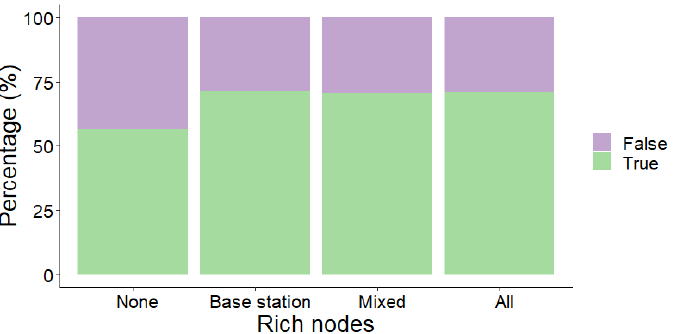
Figure 16. Deployment distribution between usage of rich nodes and existence of goal network.